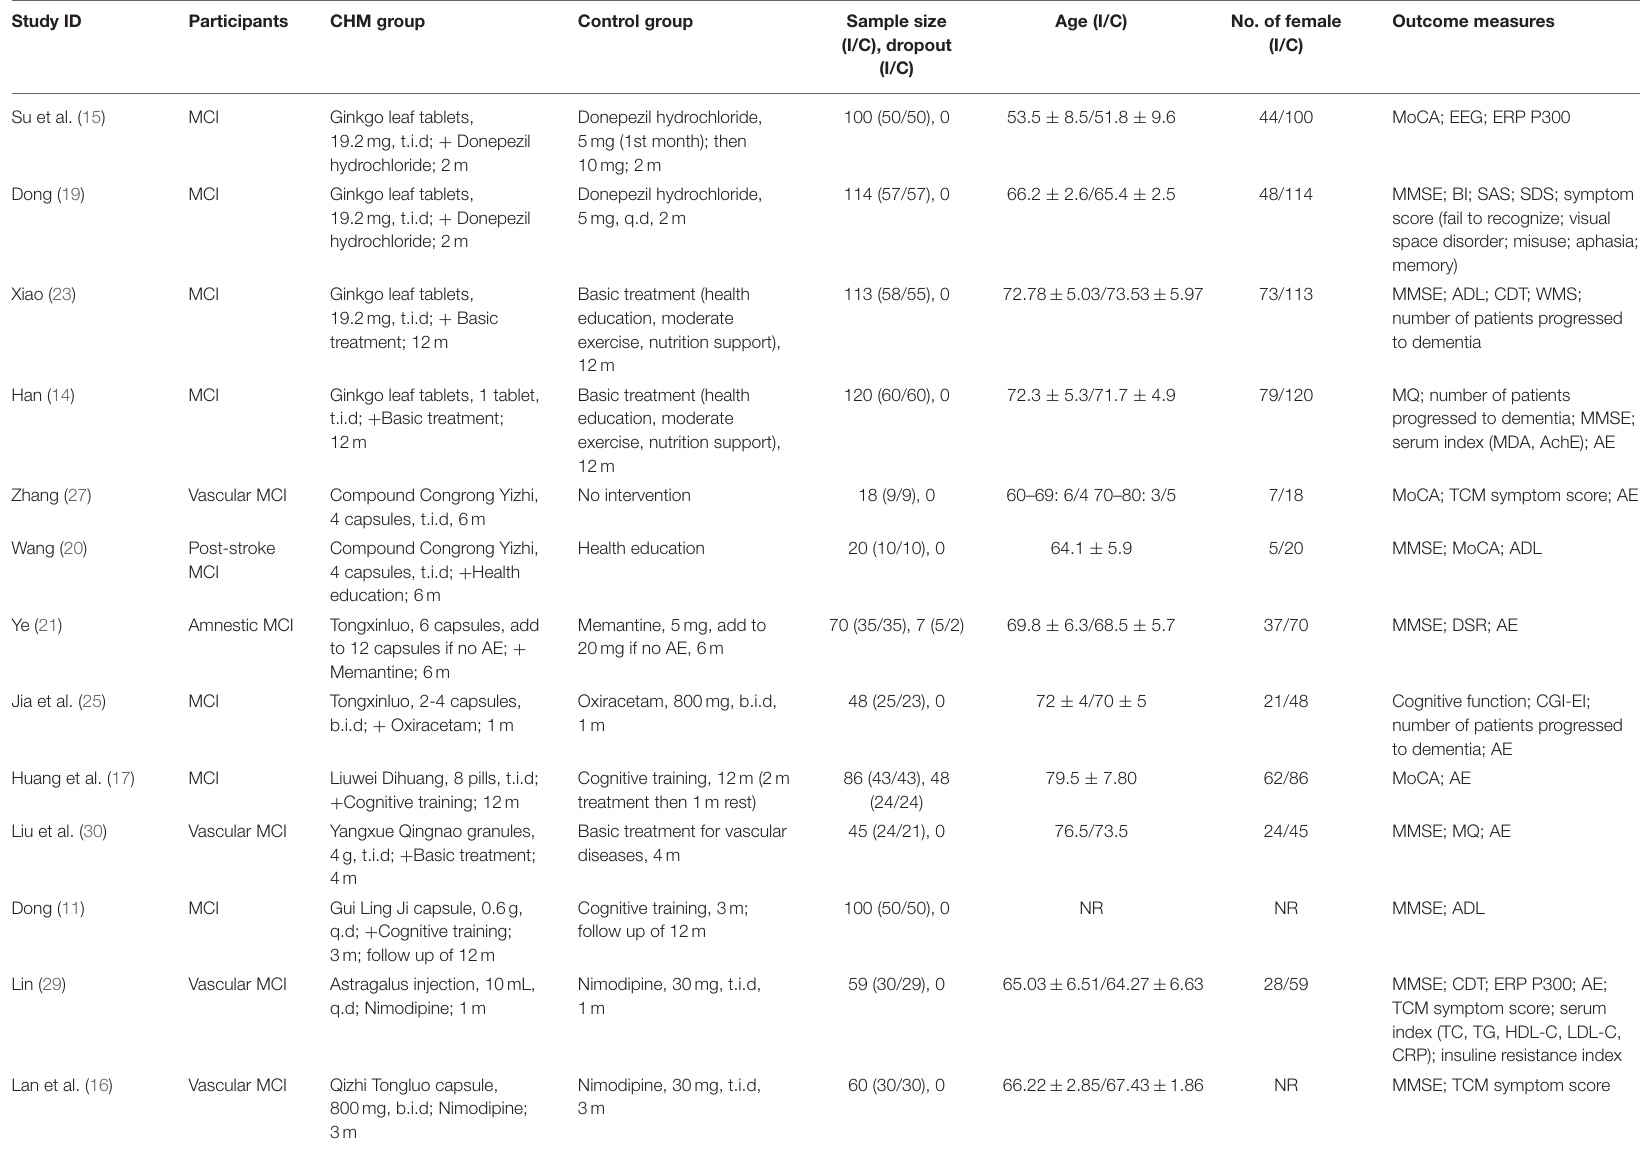
TABLE 1 | Characteristics of trials included in the